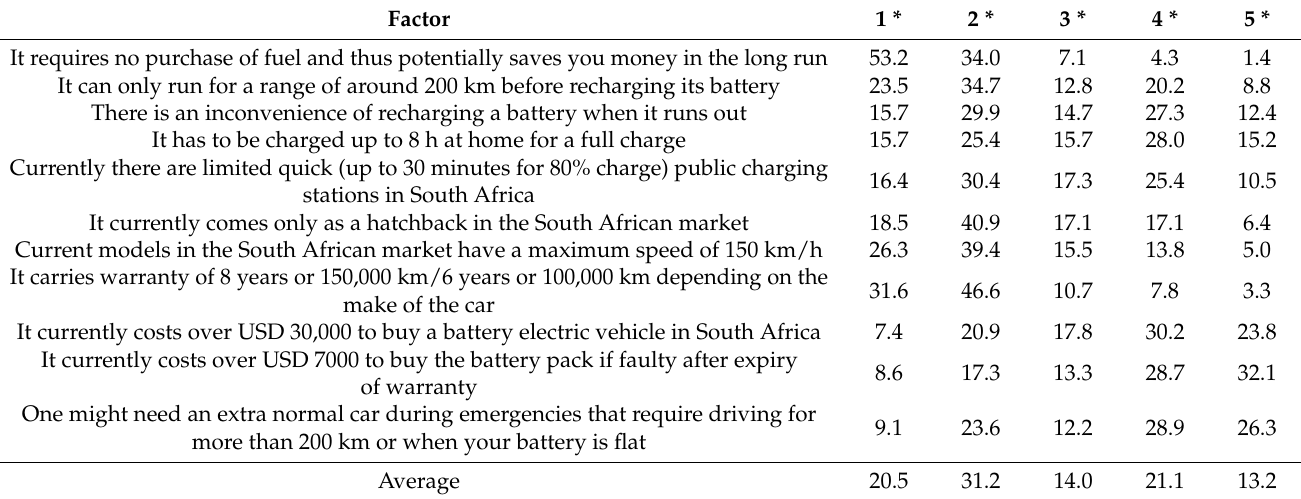
Table 4. Percentages of respondents showing the degree to which they were likely to purchase an electric vehicle based on the current